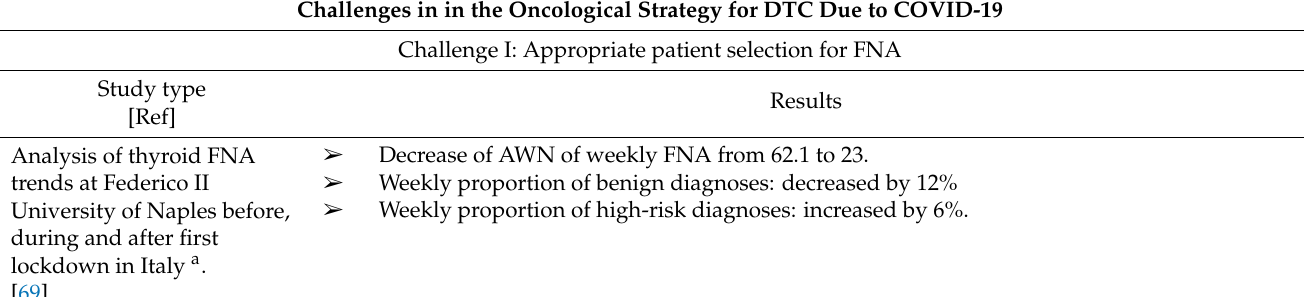
Table 4. The challenges in the oncological strategy for DTC due to COVID-19 pandemic. Challenges in in the Oncological Strategy for DTC Due to COVID-19 Challenge I: Appropriate patient selection for